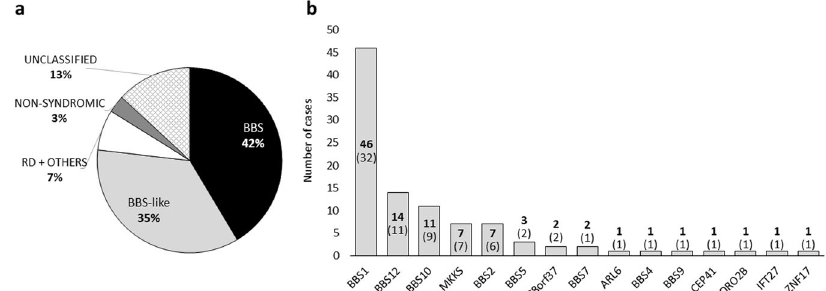
Fig. 1 Clinical classi fi cation and genetic distribution of the cohort. a A priori clinical classi fi cation. All patients have been classi fi ed into fi ve categories: (i) Bardet – Biedl syndrome ( “ BBS ” ); (ii) suspected of BBS ( “ BBS-like ” ); (iii) “ RD + OTHERS ” ; (iv) “ NON-SYNDROMIC ” ; and (v) “ UNCLASSIFIED ” . b Distribution of the causative biallelic genes found in the complete cohort. Bold numbers indicate the total number of cases genetically diagnosed for each gene, while the number of families to which these cases belong is indicated in